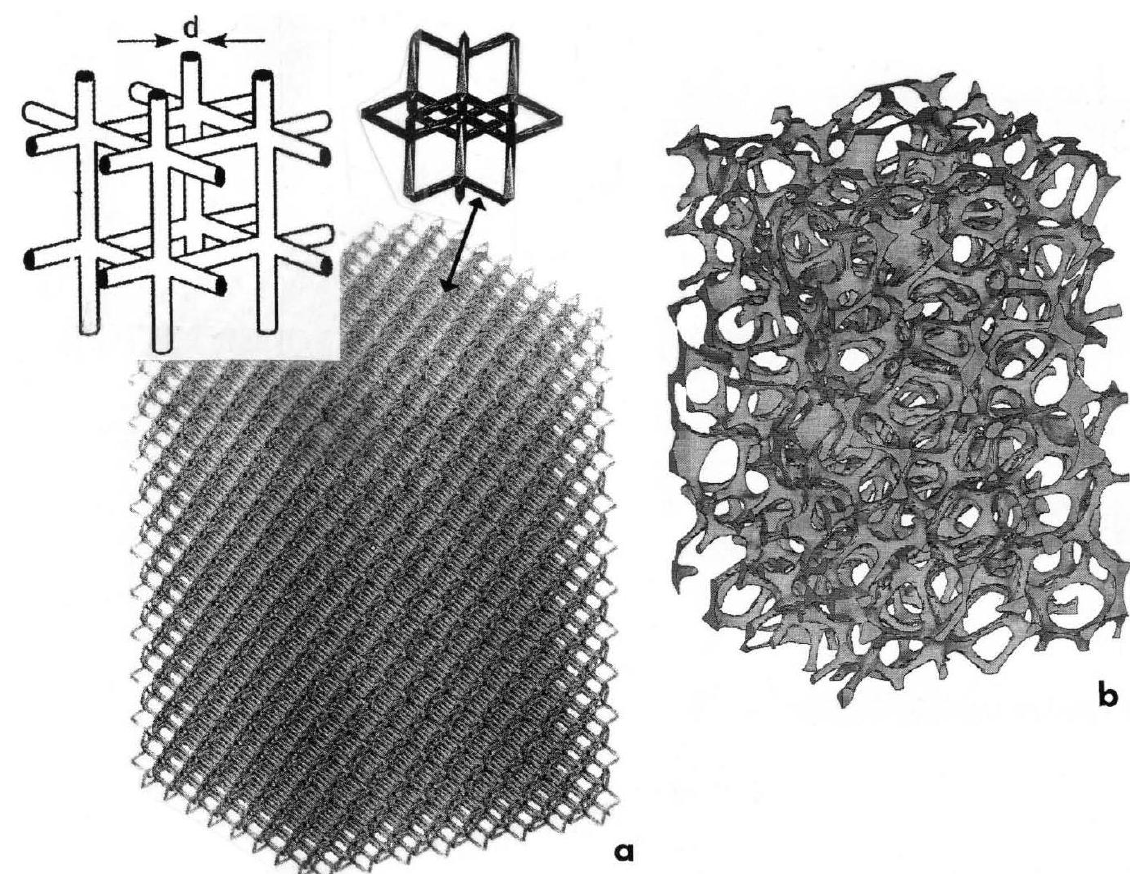
Figure 1. CAD-models for EBM fabrication of open-cellular structures. ( a ) Dode-thin (Materialise ™ ) software element (arrow) and model. A simple strut structure having strut diameter, d, is shown inserted upper left. ( b ) Cellular foam model based on microCT scan